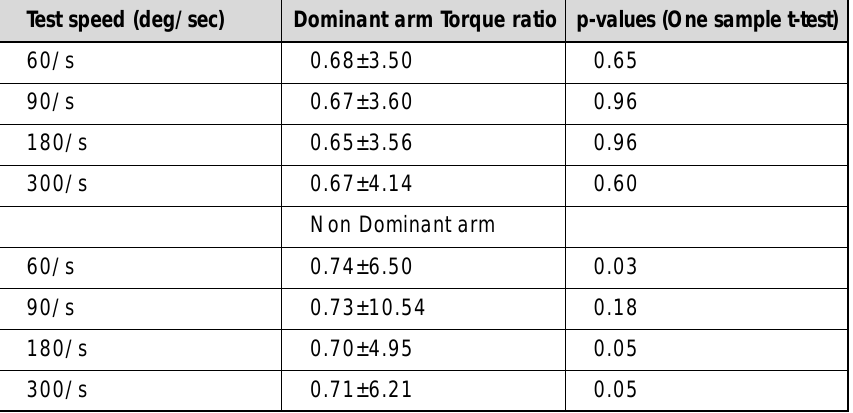
Table 3: The comparison of mean torque ratios for shoulder external and internal rotation between the dominant and non dominant bowling arms.